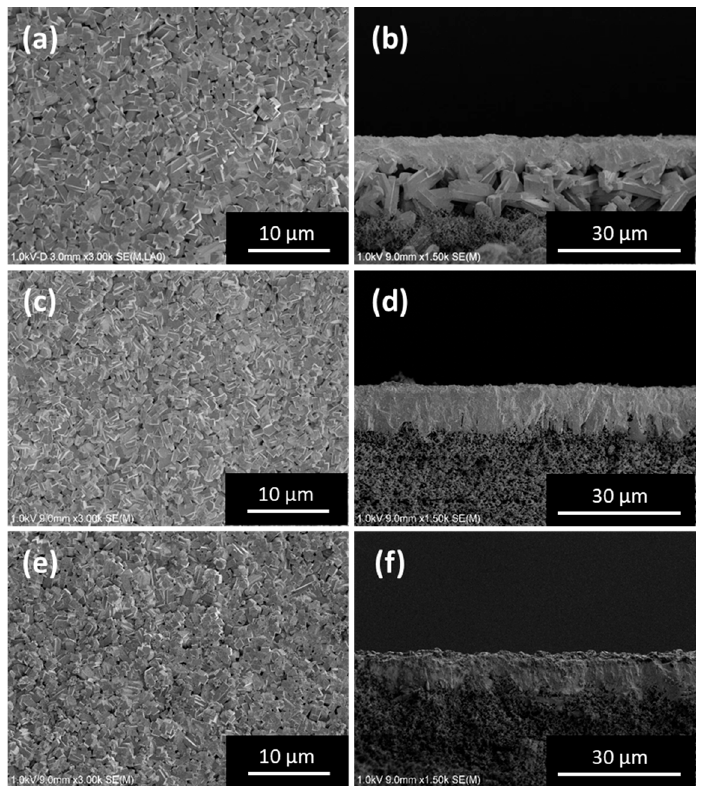
Figure 3. Top (left) and cross-sectional (right) SEM images of silicalite-1 membranes fabricated using uncoated and silica-particle-coated (different types of particles) silica supports by gel-free SAC method. ( a , b ) Uncoated silica support for 24 h, ( c , d ) spherical-silica-particle-coated silica support for 24 h, and ( e , f ) fumed-silica-particle-coated silica support for 16 h.